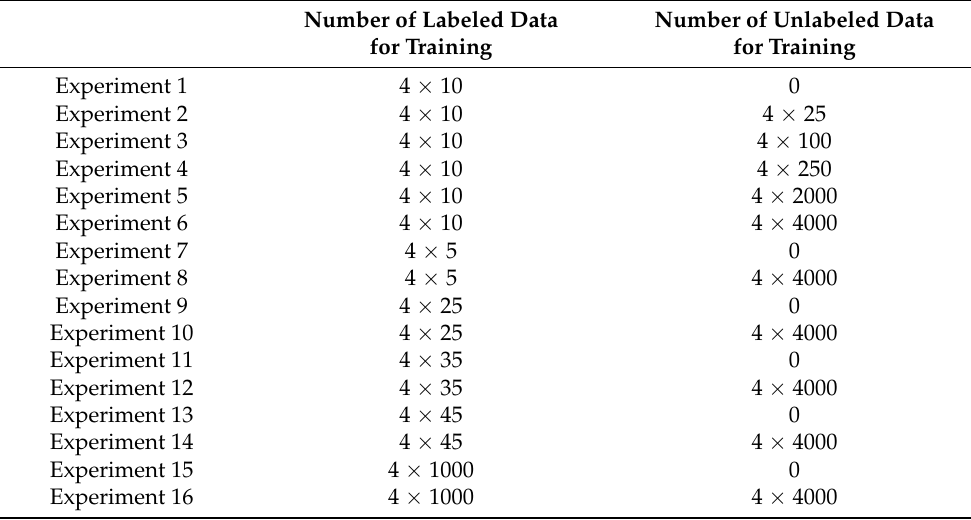
Table 3. Experiment design for semi-supervised fault